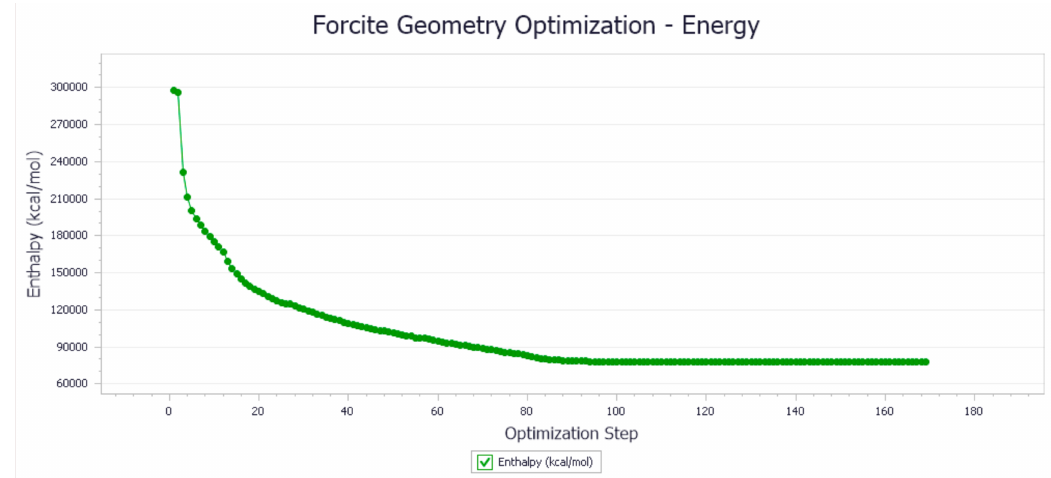
Figure 10. Demulsifier6 # oil–water interface geometry optimization energy trend.